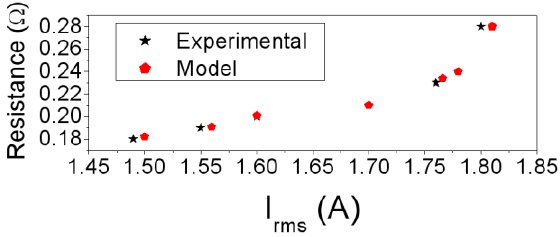
IR  curve. Experiment (    ) and 2D simulation (    ). rms